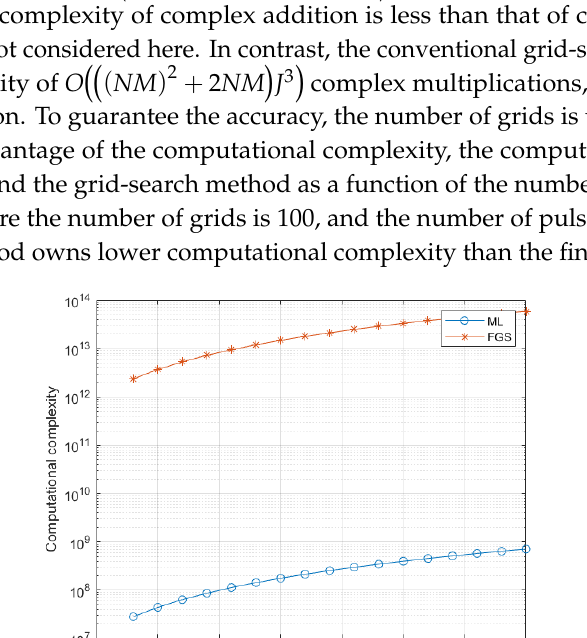
( b ) Figure 2. Echo plane after matched filtering. ( a ) Frequency non-agile case; ( b ) Frequency agile case